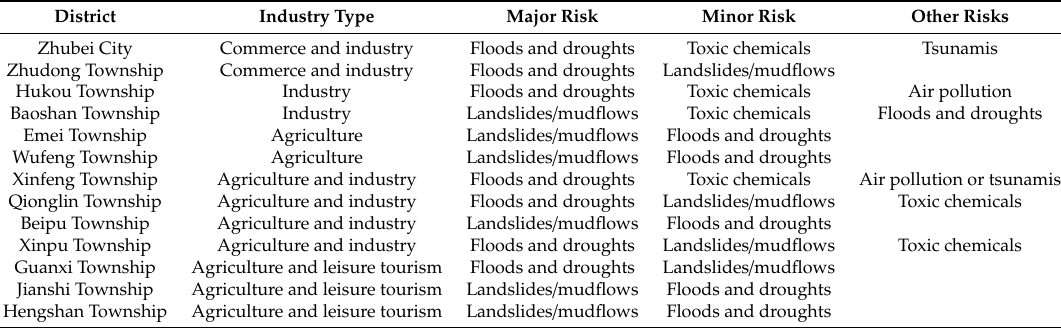
Figure 1. Main industry types of 13 townships and cities in Hsinchu County. Table 1. Main industrial characteristics and potential disaster risks of 13 townships and cities in Hsinchu